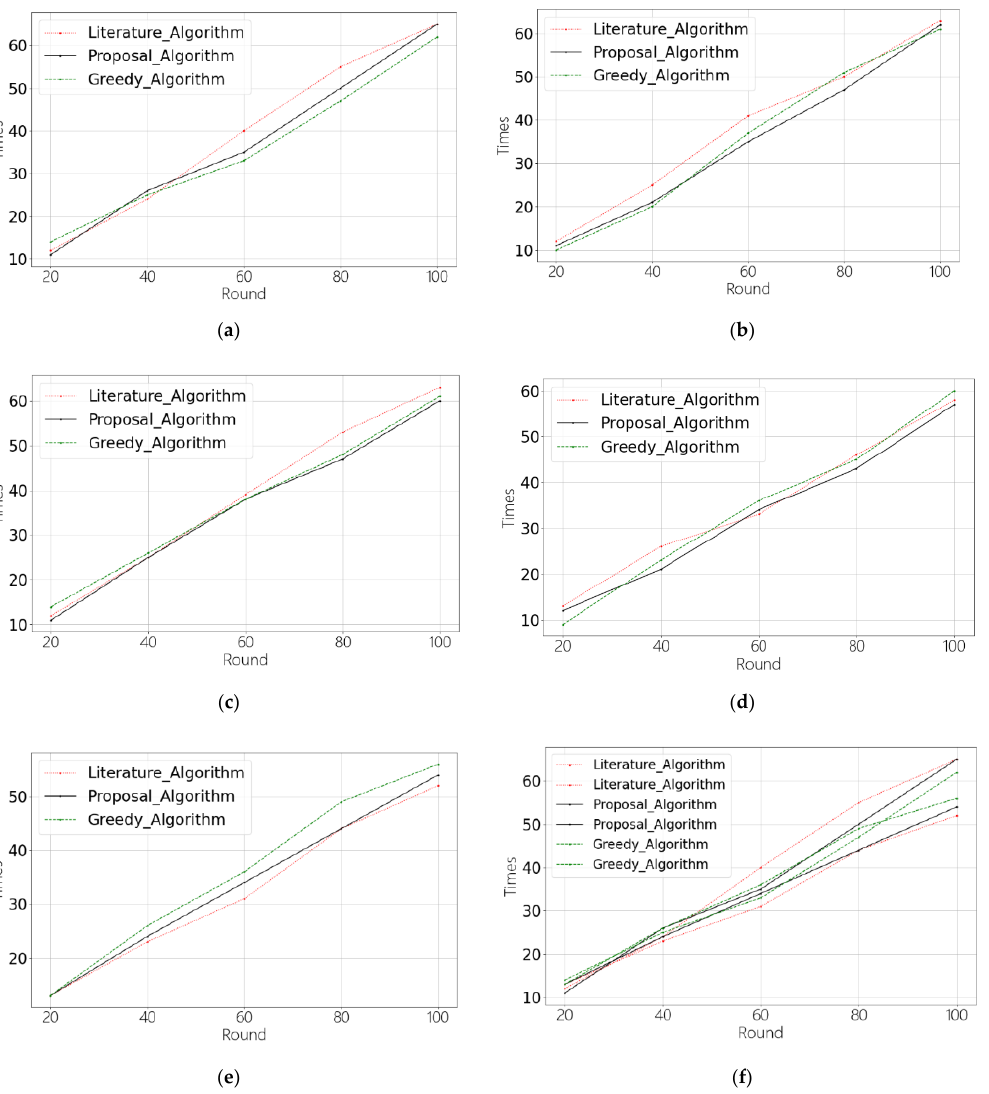
Figure 5. Comparison of algorithms under the same reputation values. ( a ) Node1; ( b ) Node2; ( c ) Node3; ( d ) Node4; ( e ) Node5; ( f ) comparison between the most selected nodes and the least selected nodes.